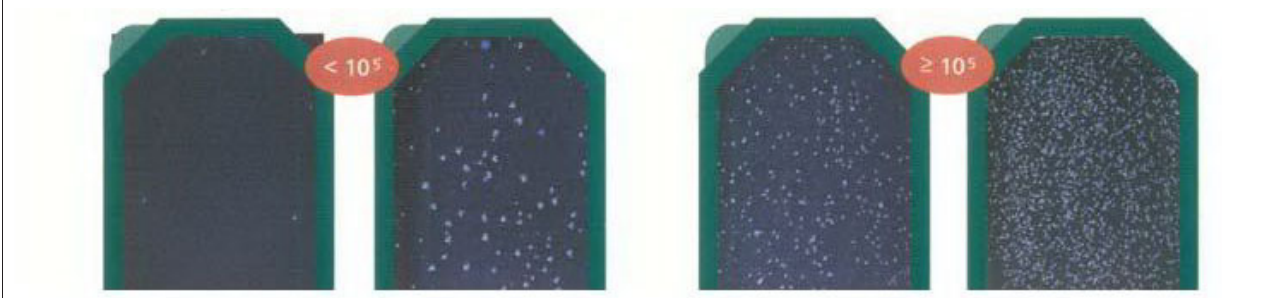
Fig. 1 - Mutans Streptococci (CFU/ml